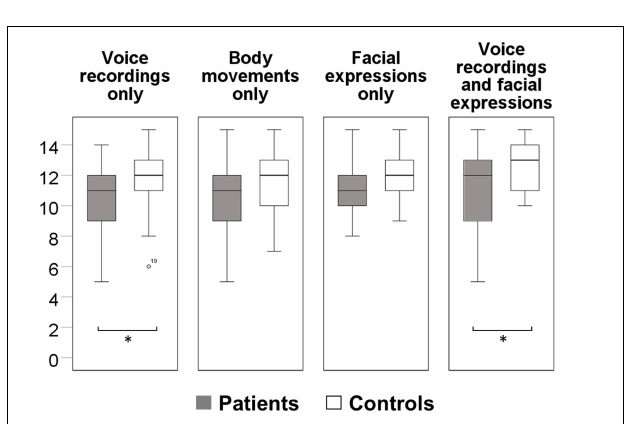
FIGURE 1 | Group difference in nonverbal social perception. ∗ denotes significant differences p -value < 0.05, whilst controlling for education and working memory.